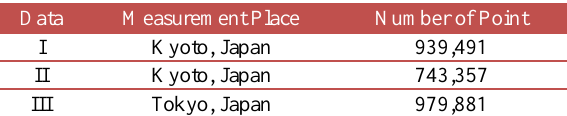
Table 1. Data used in the article (without the ground points)